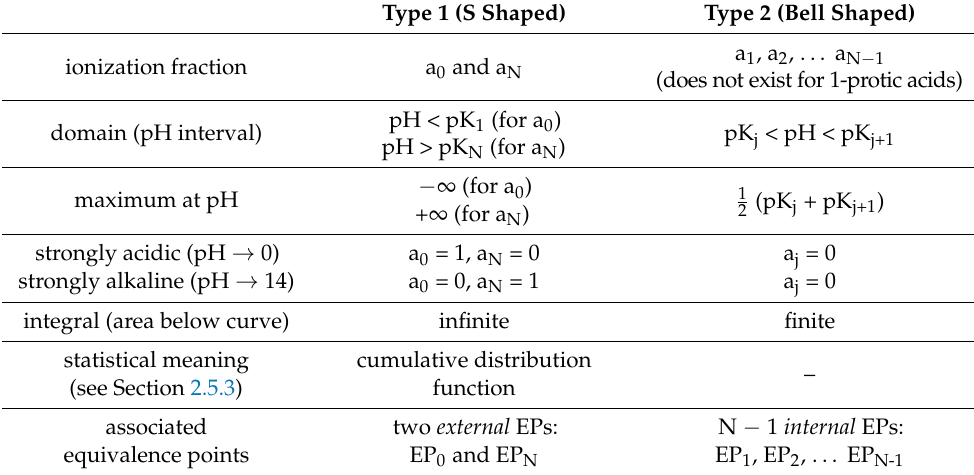
Figure 4. Each ionization fraction a j has its own domain in the pH interval between two adjacent pK j values. (HA—acetic acid, H 2 A—carbonic acid, H 3 A—phosphoric acid). Table 2 contrasts the two types of ionization fractions. Their otherness implies the distinction between external (outer) and internal (inner) equivalence points in Section 2.3. Table 2. Two types of ionization fractions.